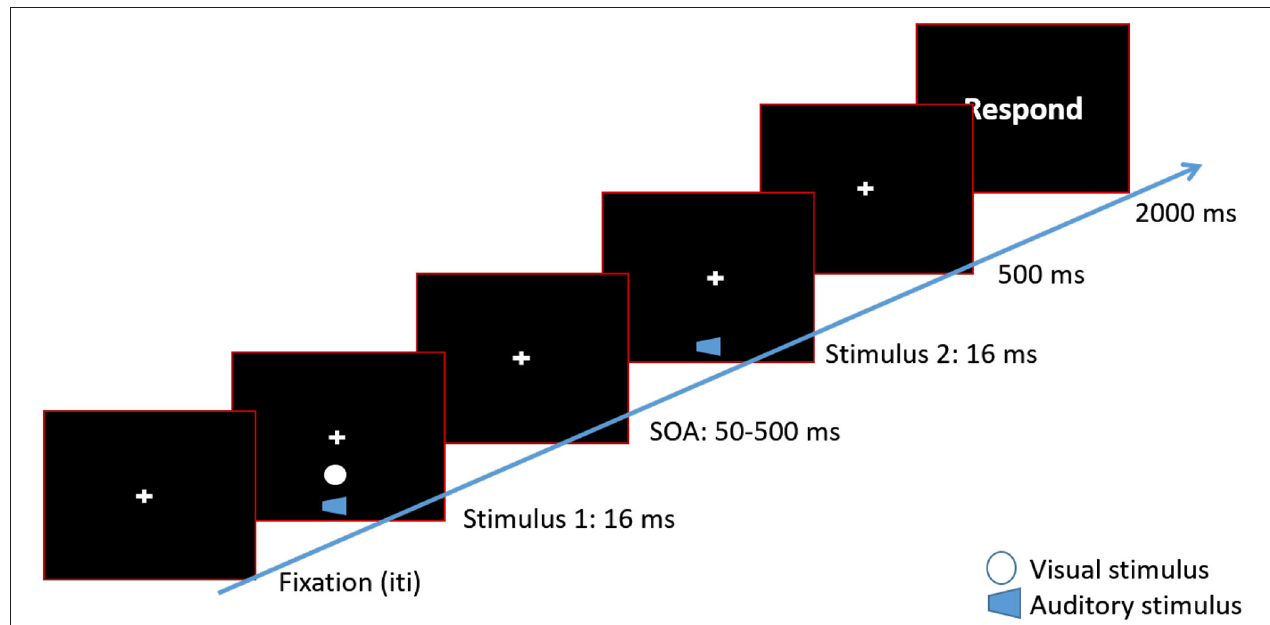
FIGURE 1 | Timeline of a 2 beeps/ 1 flash condition. Each trial began with a fixation cross at the center of the screen. After a variable inter-trial interval, a white disk (flash) was presented along with a 3,500 Hz tone (beep) for 16 ms . The visual disk was presented approximately 8 ◦ of visual angle below the fixation cross. After a variable SOA, the second beep was presented. In the 2 beeps/ 2 flashes condition a second white disk would be presented along with the second beep. After 500 ms , a response screen was presented. Participants waited for the response screen to make their button